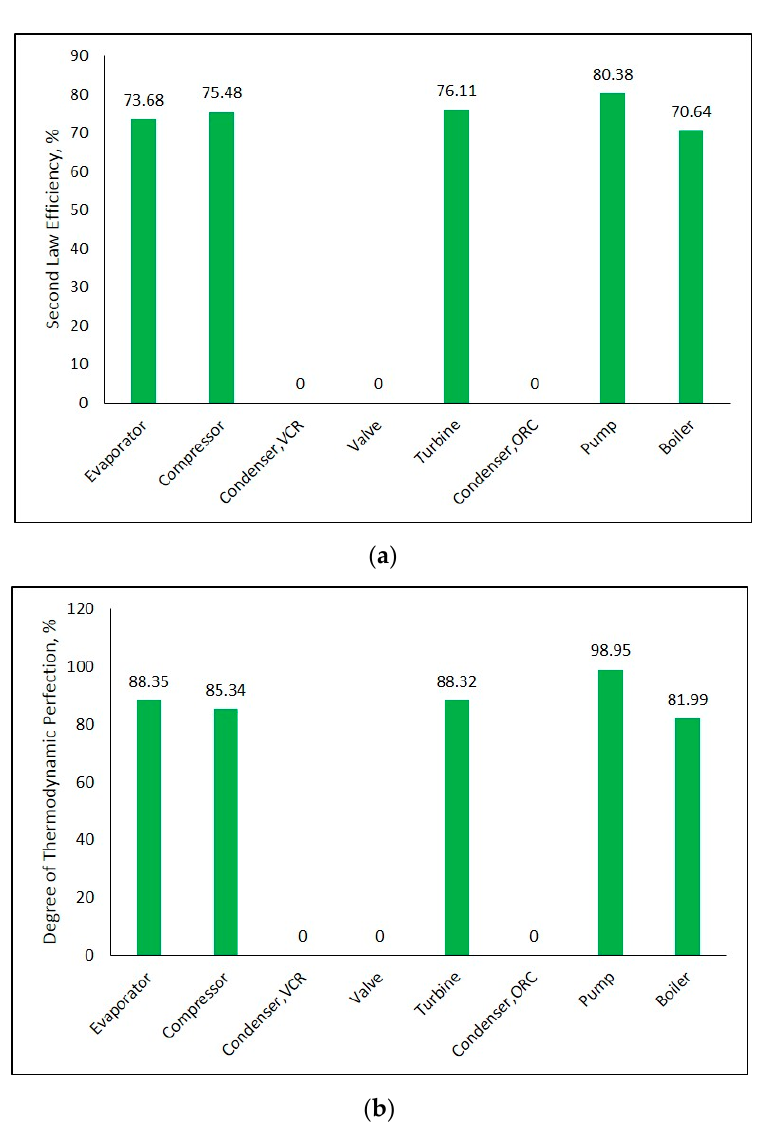
Figure 12. Second law efficiency ( a ) and degree of thermodynamic perfection ( b ) for each component in combined ORC-single evaporator VCR cycle.